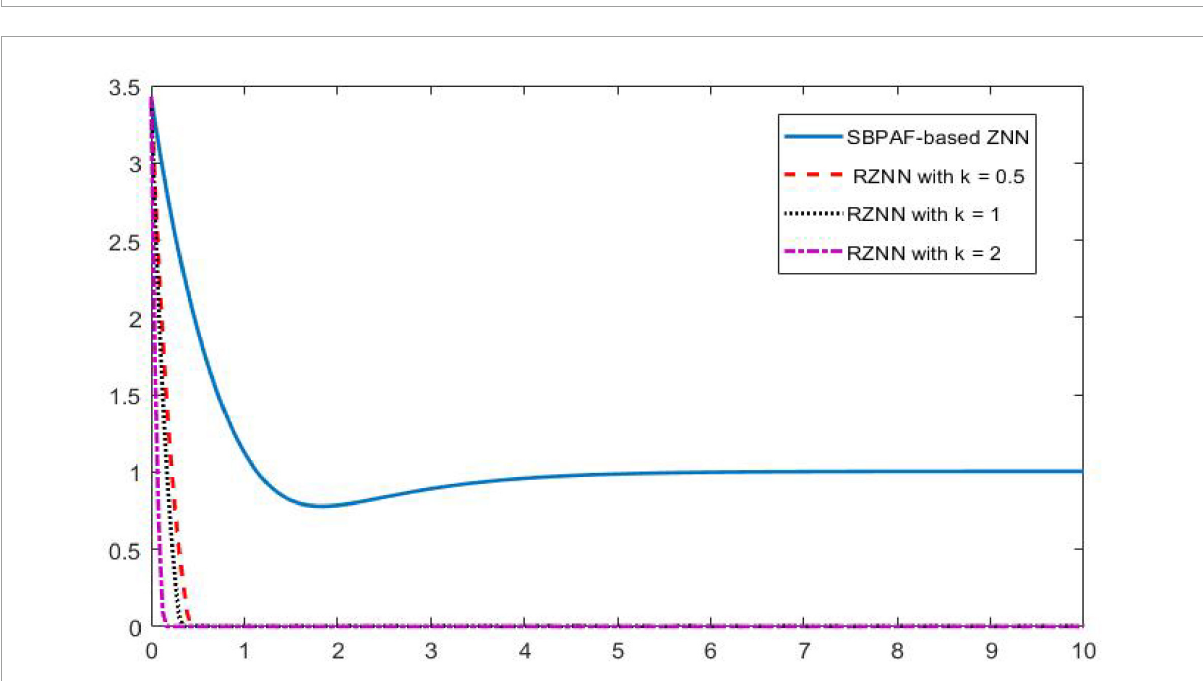
FIGURE10 Residual errors of robust zeroing neural network (RZNN) model (11) and sign-bi-power activation function (SBPAF)-based ZNN model (8) in n(t) = 0.5 polluted environment.